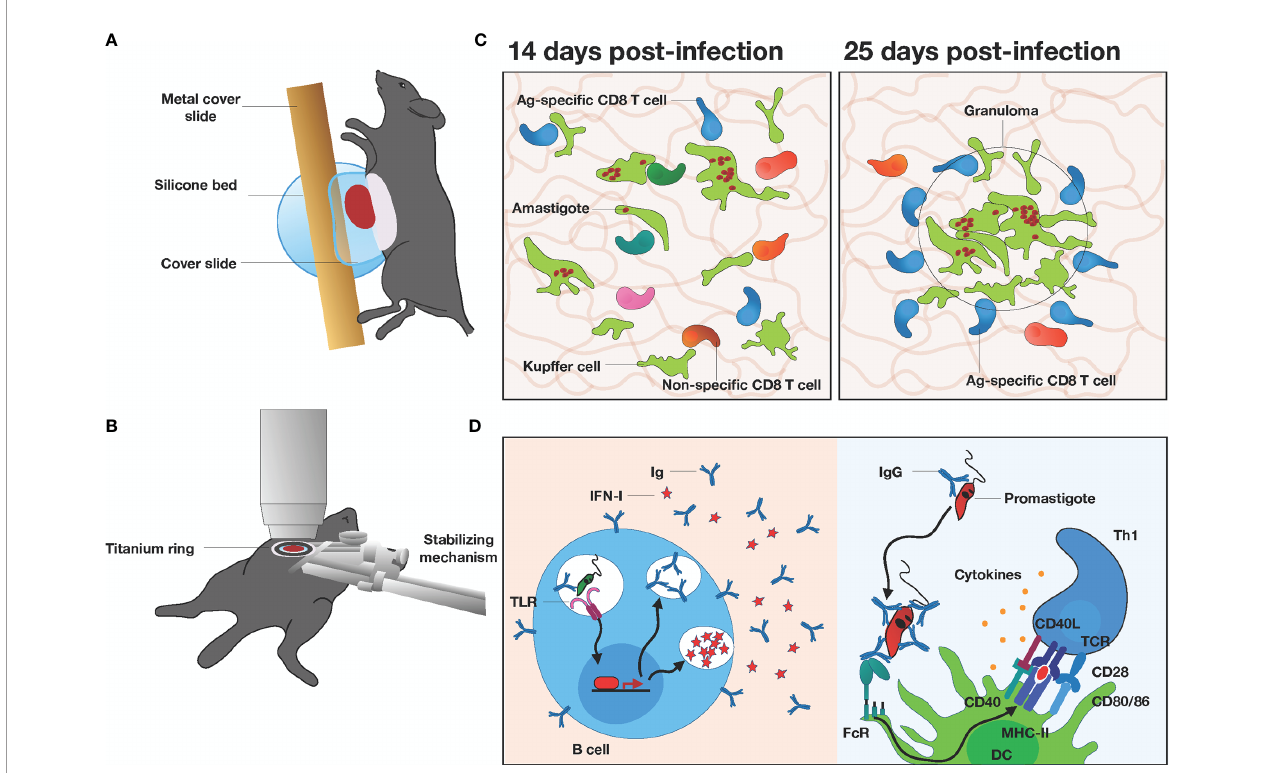
FIGURE 2 | In vivo microscopy of the liver in Leishmania -infected mice (A) Graphical illustration of a mouse preparation for short-term liver imaging. Liver is externalized, placed onto the silicone bed, and covered with a custom metal cover slide. (B) Graphical illustration of a mouse preparation for long-term liver imaging. A titanium ring is surgically inserted into the mouse abdomen and connected to a custom stabilizing mechanism. (C) Granuloma formation in the liver at 14 vs 25 days post infection with Leishmania donovani . CD8 + T cells are recruited to the granuloma irrespective of antigen speci fi city, but antigen speci fi c CD8 + T cells are retained at 25 days. (D) Pathogenic and protective roles of B cells in Leishmania immunity. Leishmania donovani can trigger endosomal TLR stimulation, induce hypergammaglobulinemia and increase type I interferons (IFN-I) expression (left panel). IgGs from B cells facilitate opsonization of Leishmania major parasites by DCs via Fc receptors to drive effector Th1 activation (right